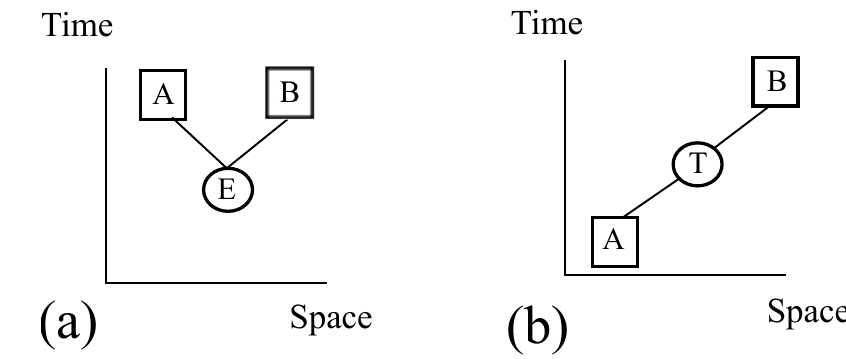
Figure 3. Two dual experiments, with measurements by Alice (A) and Bob (B). For known measurement settings, there is always a duality between any entangled source (E) and some particular intermediate transformation